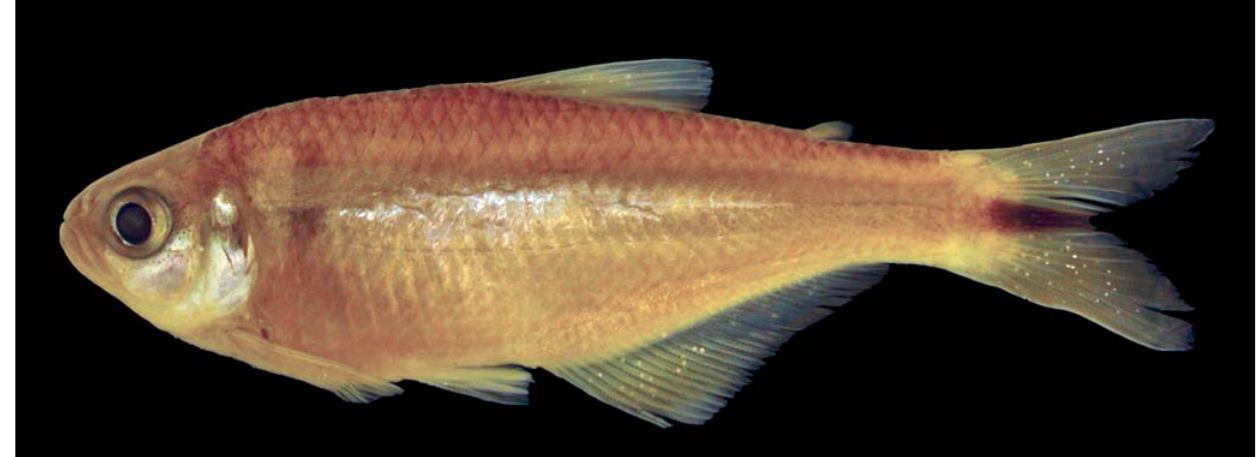
Fig. 23. Hemibrycon taeniurus , AMNH 215239, male, 68.5 mm SL, Island of Trinidad, Trinidad and Tobago.